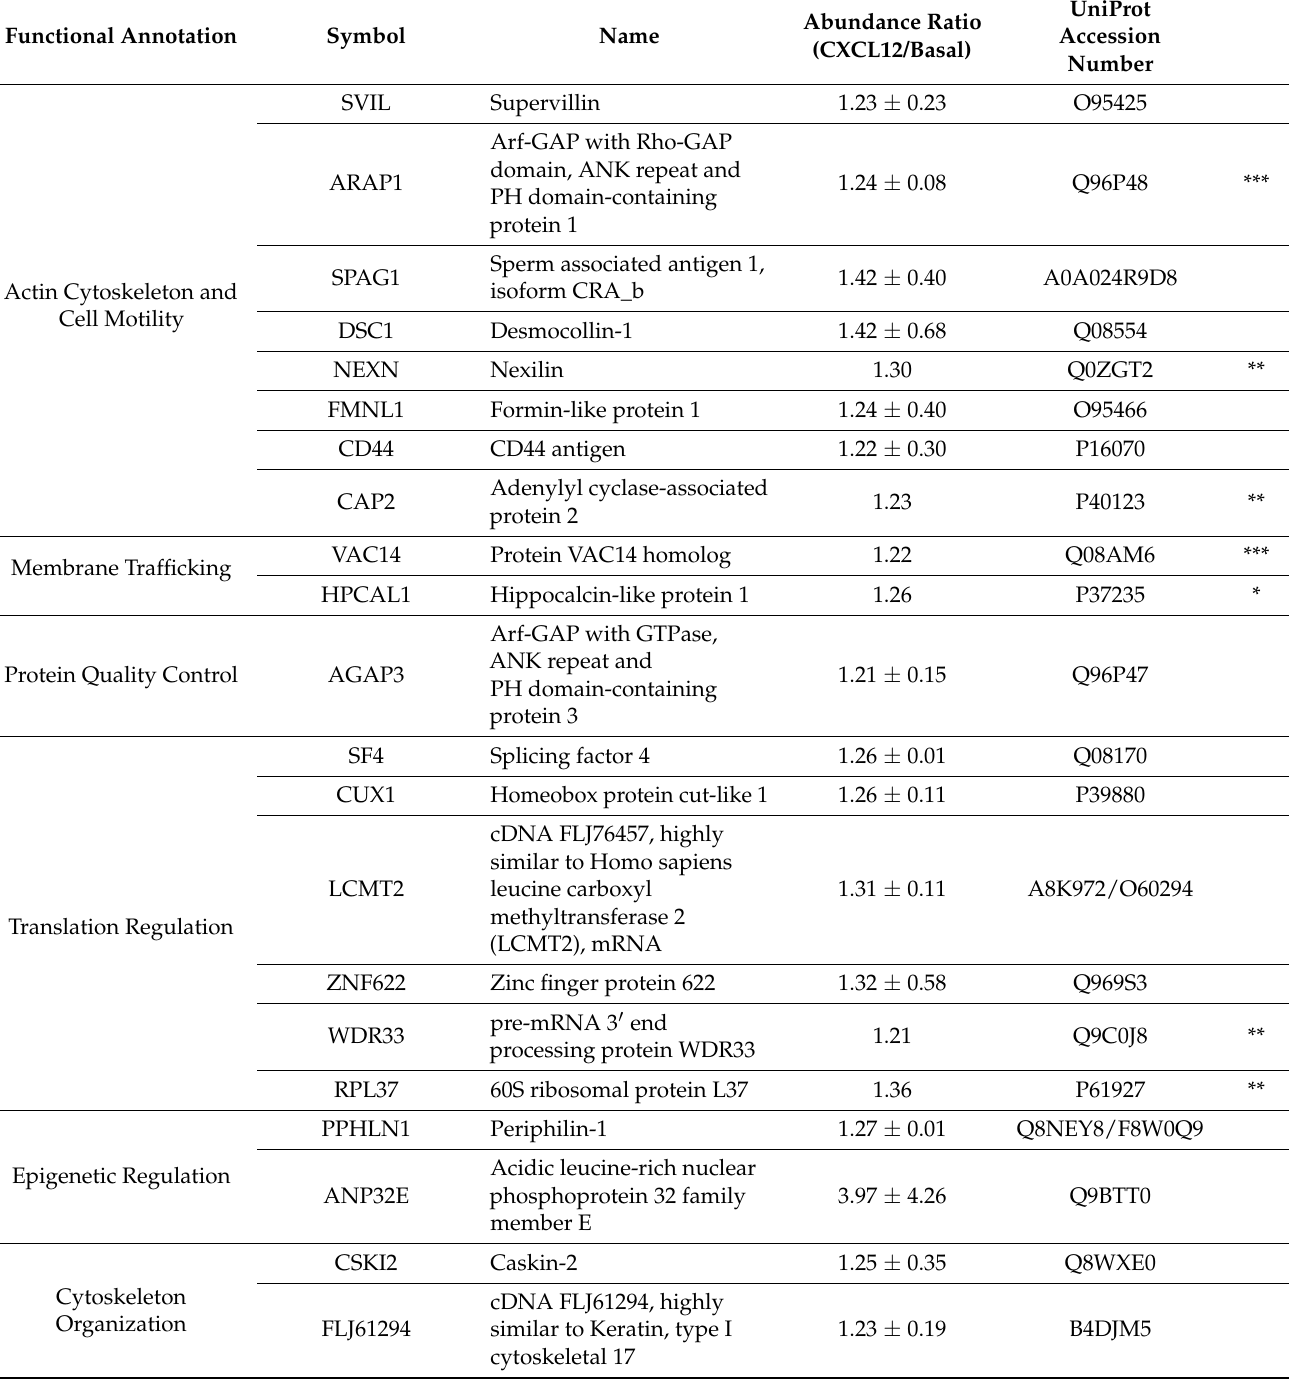
Table 2. Proximity labeled proteins that were not considered to be high confidence β -arrestin1- interacting proteins. Proteins are classified based on their functional annotation. The abundance ratios are the average from three independent experiments ± the standard deviation. One asterisk (*) indicates proteins identified at 60 min of CXCL12 stimulation and in one biological replicate. Two asterisks (**) indicates proteins identified in one biological replicate. Three asterisks (***) indicates proteins identified at 5 min and 60 min of CXCL12